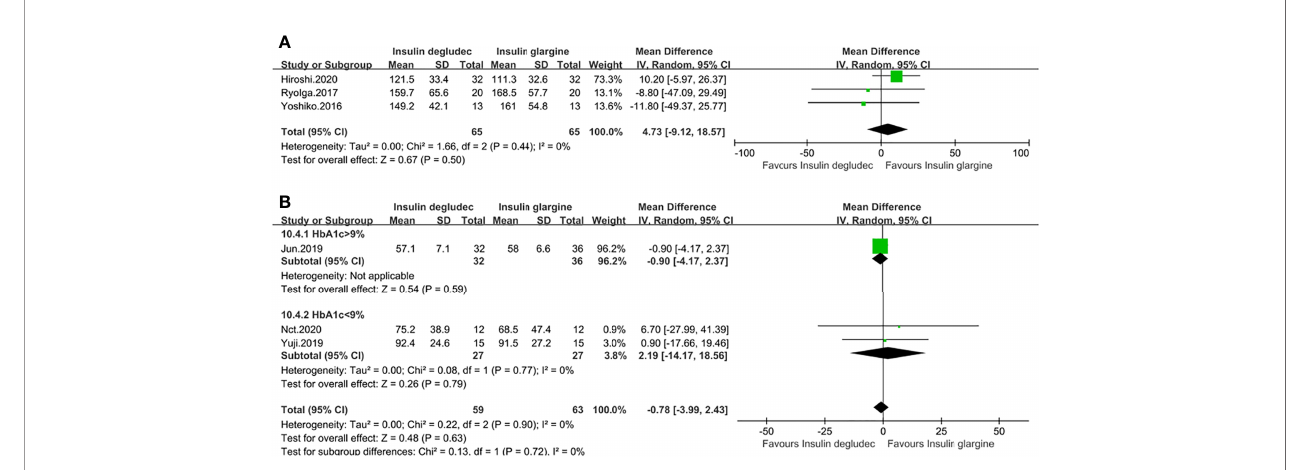
FIGURE 5 | Forest plot for the MAGE. (A) MAGE in patients with type 1 diabetes; (B) MAGE in patients with type 2 diabetes.